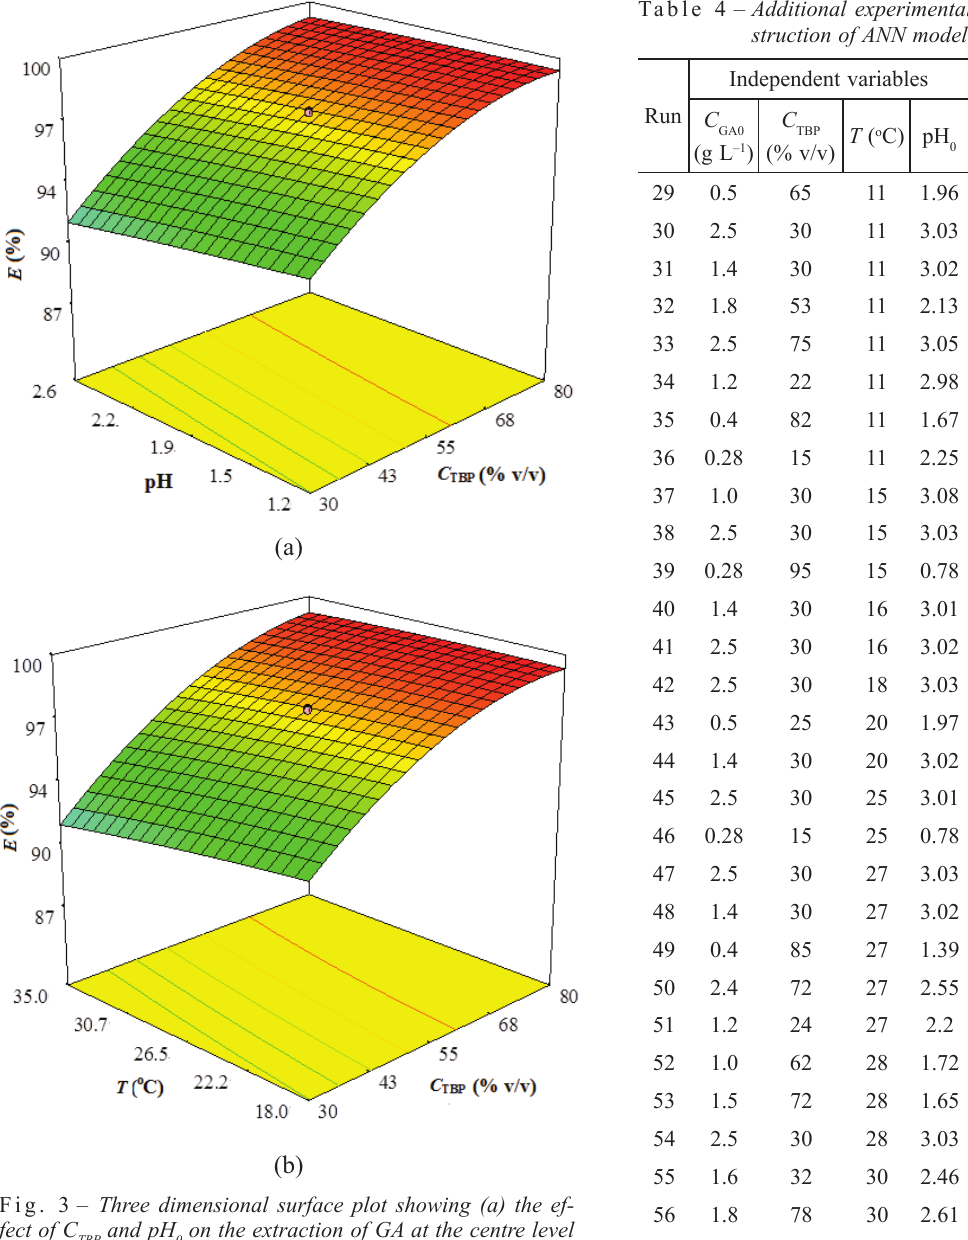
and T TBP = 1.9, C = 0 GA0